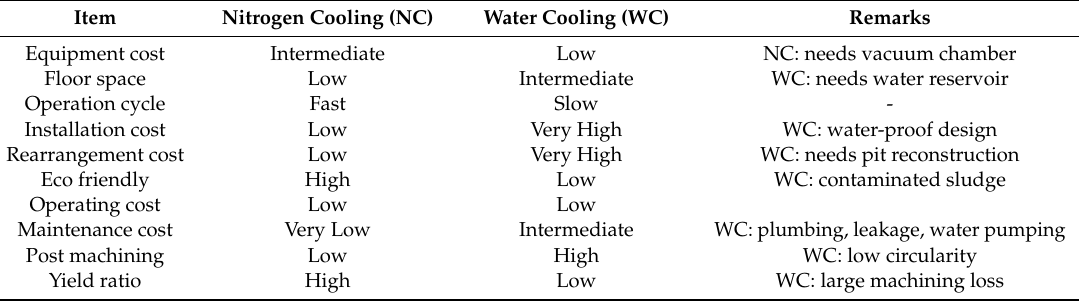
Table 2. Comparison of costs for both nitrogen and water